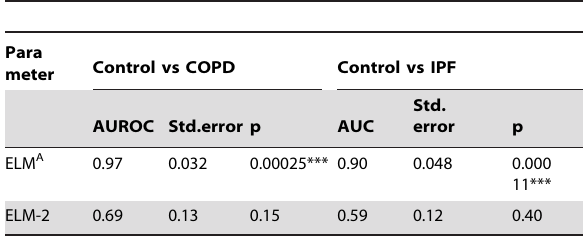
Table 5. ROC values of ELM and ELM-2 in the lung disease